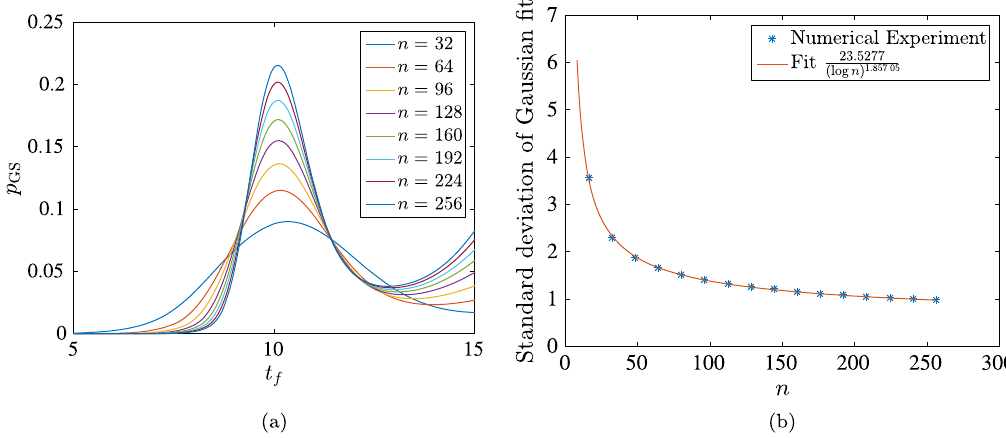
,FIG. 12. Scaling of the p problem sizes n . The peak at t peak. Plotted is the standard deviation of the fitted Gaussians as a function of n . An inverse polylogarithmic function provides an excellent fit to this